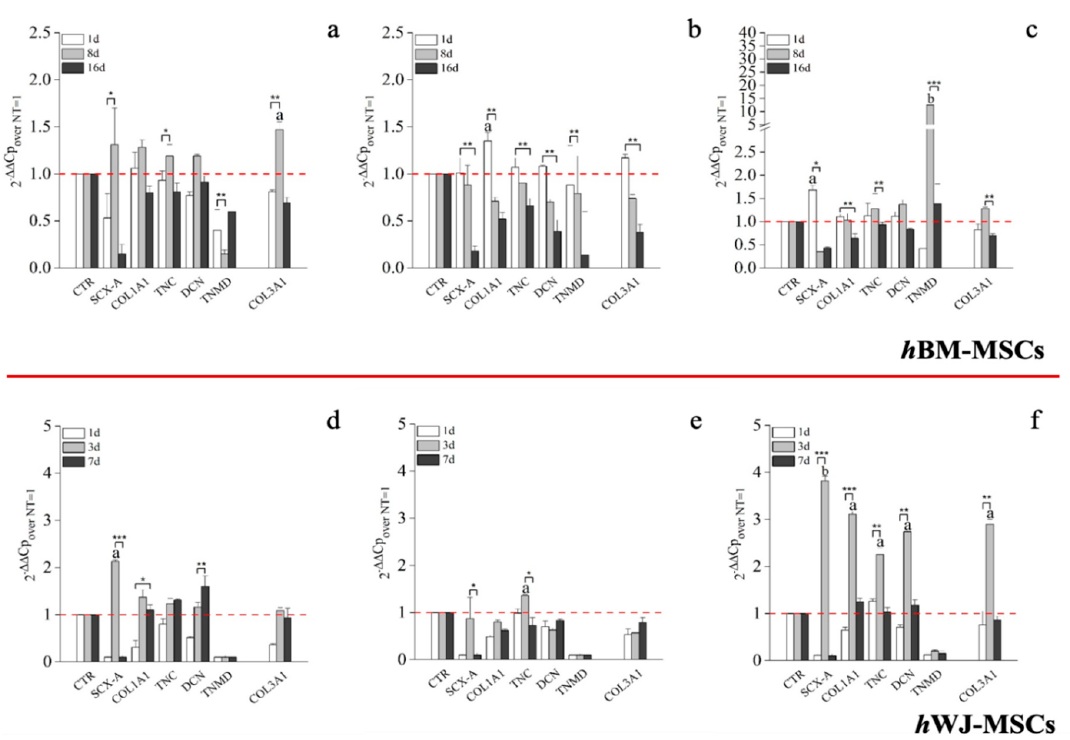
Figure 4. Real-Time Polymerase Chain Reaction (RT-PCR) on the expression of tenogenic markers by hBM-MSCs and hWJ-MSCs with the hGDF-5 dose-dependent effect. The mRNA levels of tenogenic markers (Type 3 collagen: COL3A1, type 1 collagen: COL1A1, Decorin: DCN, Scleraxis-A: